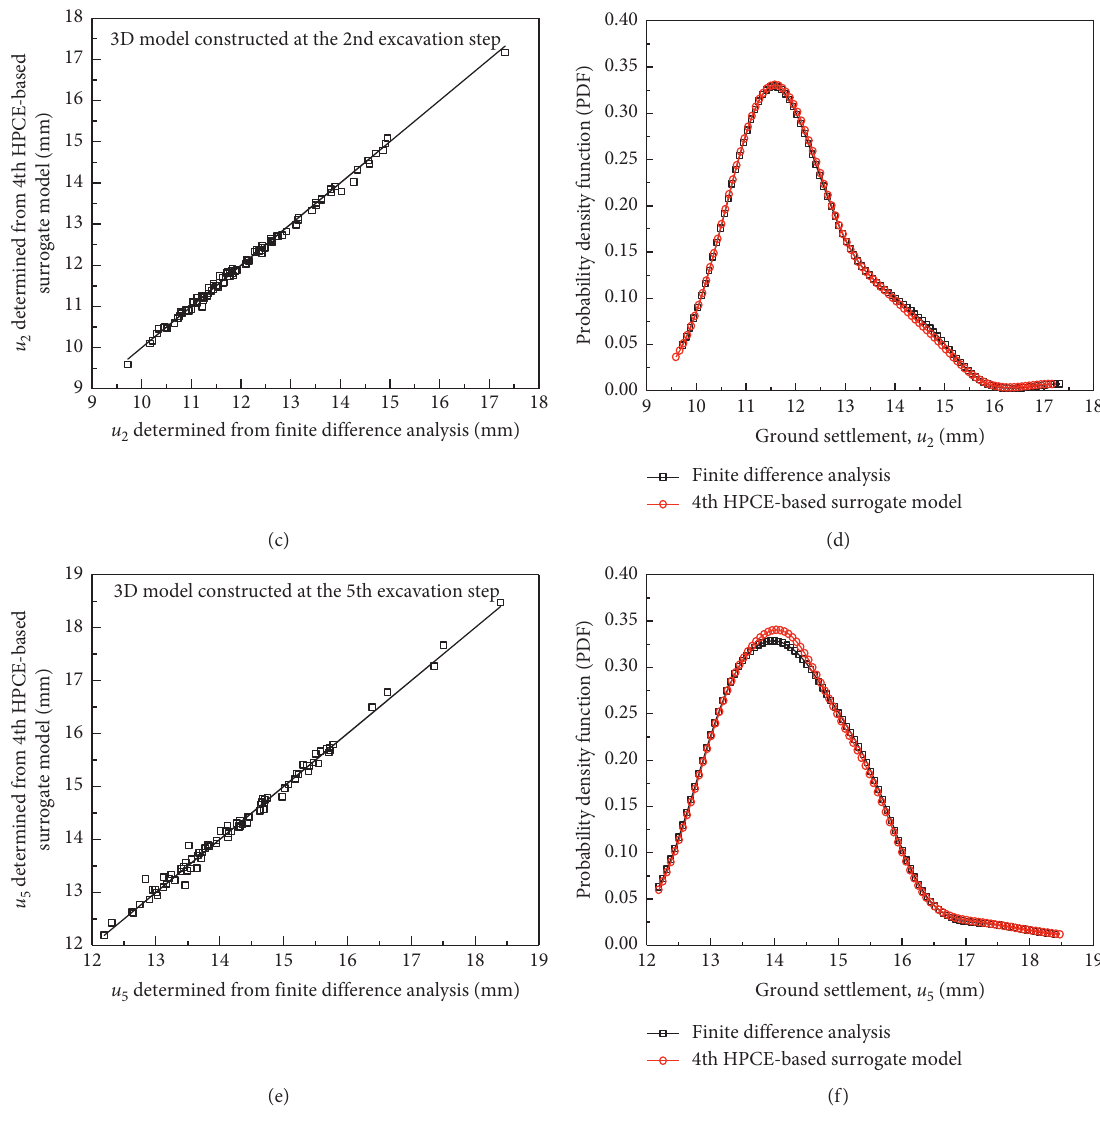
Figure 5: Validation of the surrogate models underlying three representative excavation steps. (a) Comparison of u (c) Comparison of u PDF of u 1 .